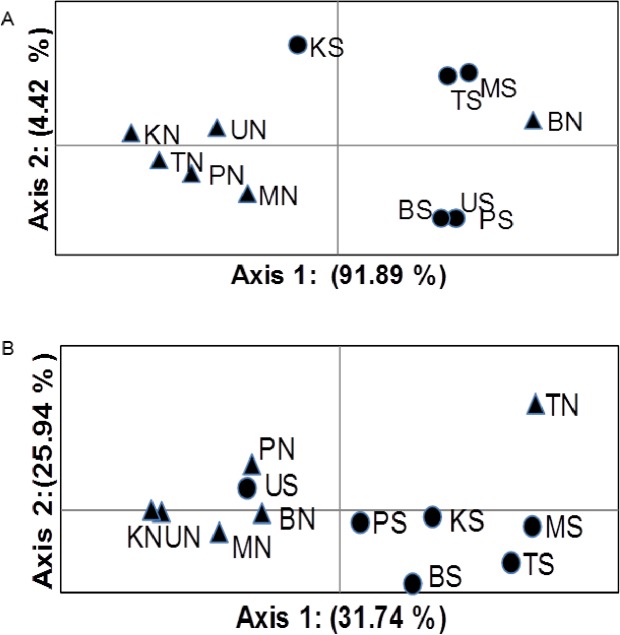
Principal coordinates analysis (PCoA) indicating population genetic differentiation based on pairwise Fst-values in the fiddler crab Austruca occidentalis from Tanzania, Western Indian Ocean.: A) COI sequences and B) microsatellites. Circles represent salt ponds and triangles natural mangroves. (TN, BN, KN, LN, MN, PN, UN) and (TS, BS, KS, LS, MS, PS, US) represent Tanga, Bagamoyo, Kilwa, Lindi, Mtwara, Pemba and Unguja natural mangroves and salt ponds sites, respectively. The percentage of variation is mainly explained by the first axis. For sequences data is 91.89% and for microsatellites data is 31.74%.